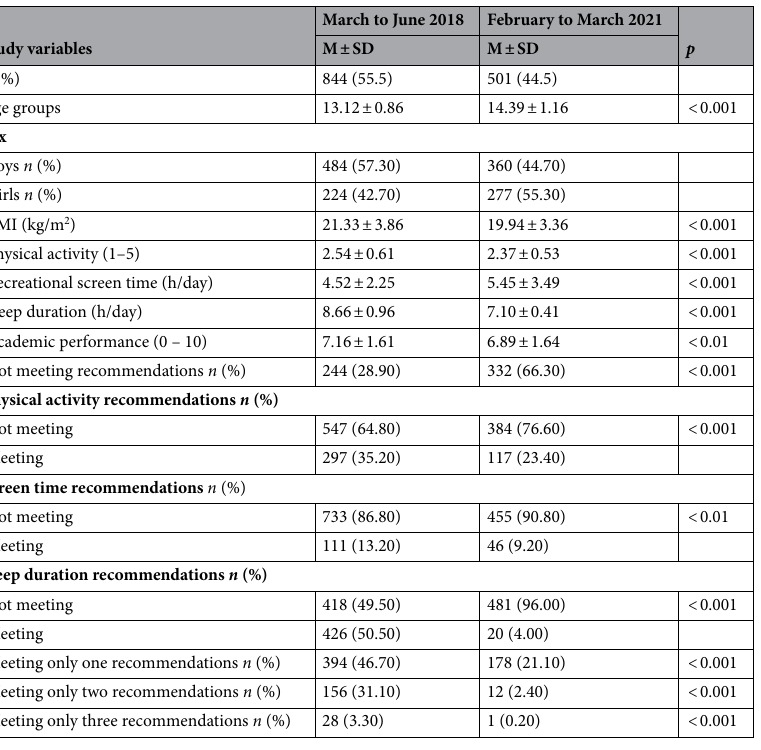
Table 1. Descriptive characteristics, prevalence of 24-Hour Movement Behaviours, and academic performance of the two-subsamples of participants before lockdown (T1) and 1-year after (T2) into the Covid-19 pandemic. Differences in the study variables between measurements taken in March to June 2018 and February to March 2021 were tested by Student t-test and Chi-squared test for continuous and categorical variables, respectively. BMI Body Mass Index.